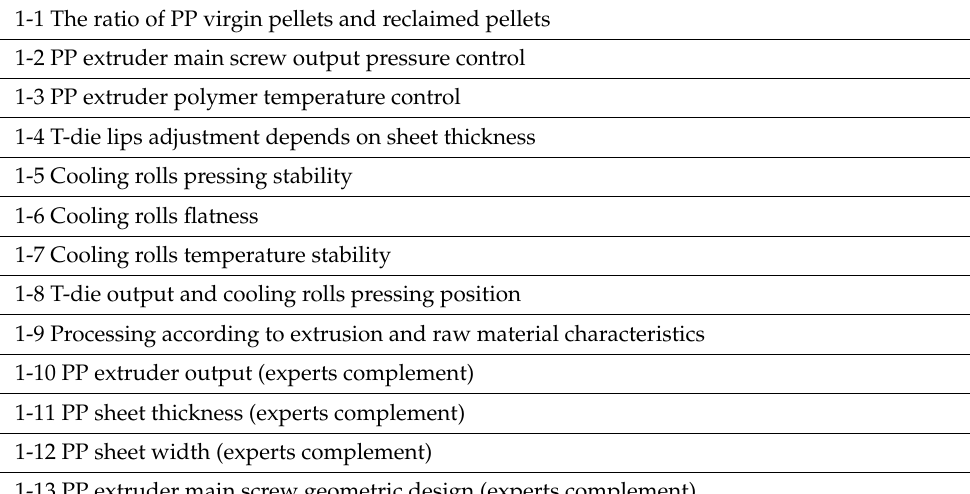
Table 2. Key factors of polypropylene extrusion sheet production (13 subitems).